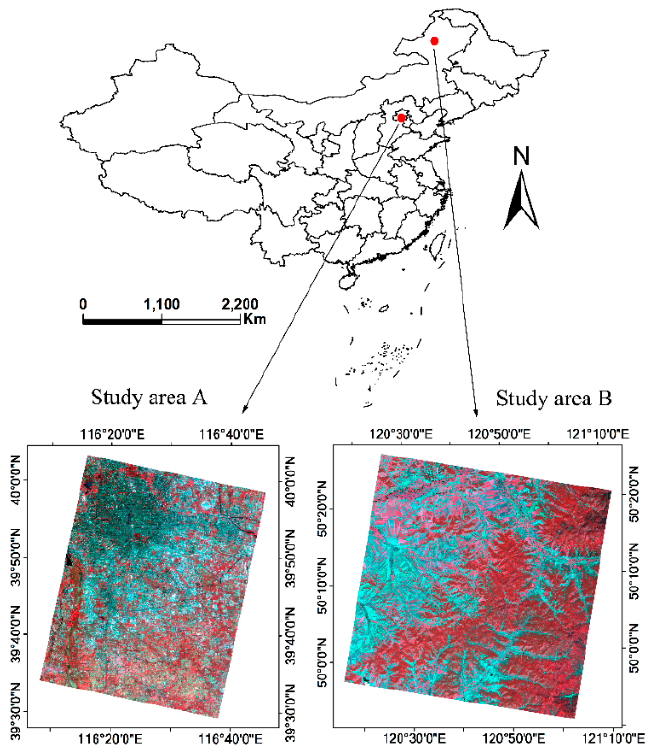
Figure 16. The study areas.